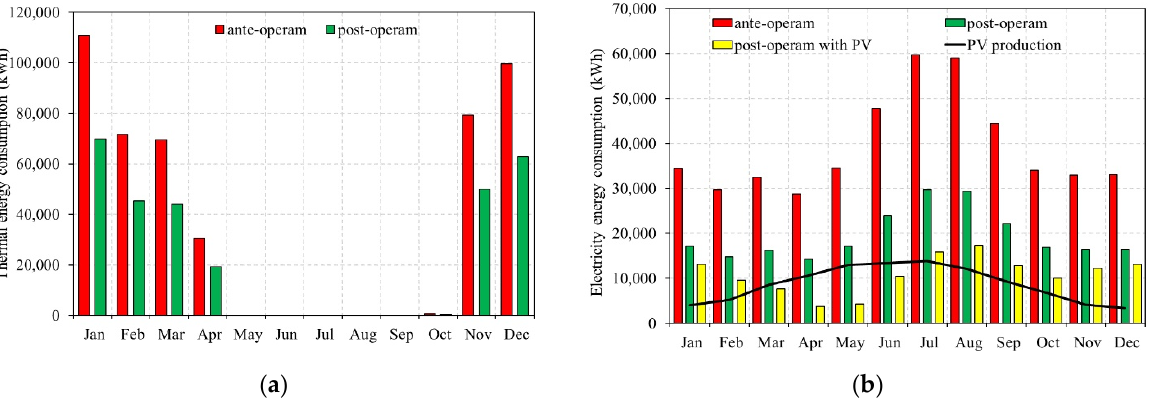
Figure 5. Comparison between ante ‐ operam and post ‐ operam energy consumption scenario of ( a ) thermal and ( b ) electricity.